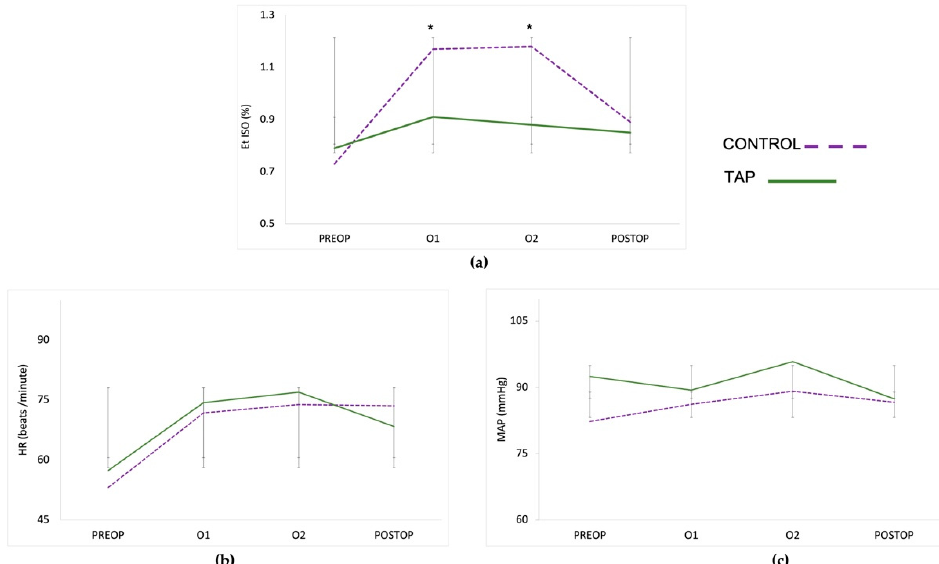
Figure 1. ( a ) Values of end-tidal isoflurane concentration (EtISO), ( b ) heart rate (HR), and ( c ) mean invasive blood pressure (MAP) at the beginning of the surgery (Preop), after the resection of the first ovary (O1), after the resection of the second ovary (O2), and at surgical closure after pneu- moperitoneum deflation (Postop). The asterisk indicates a significant difference between the two groups at those time points. * p < 0.0001.